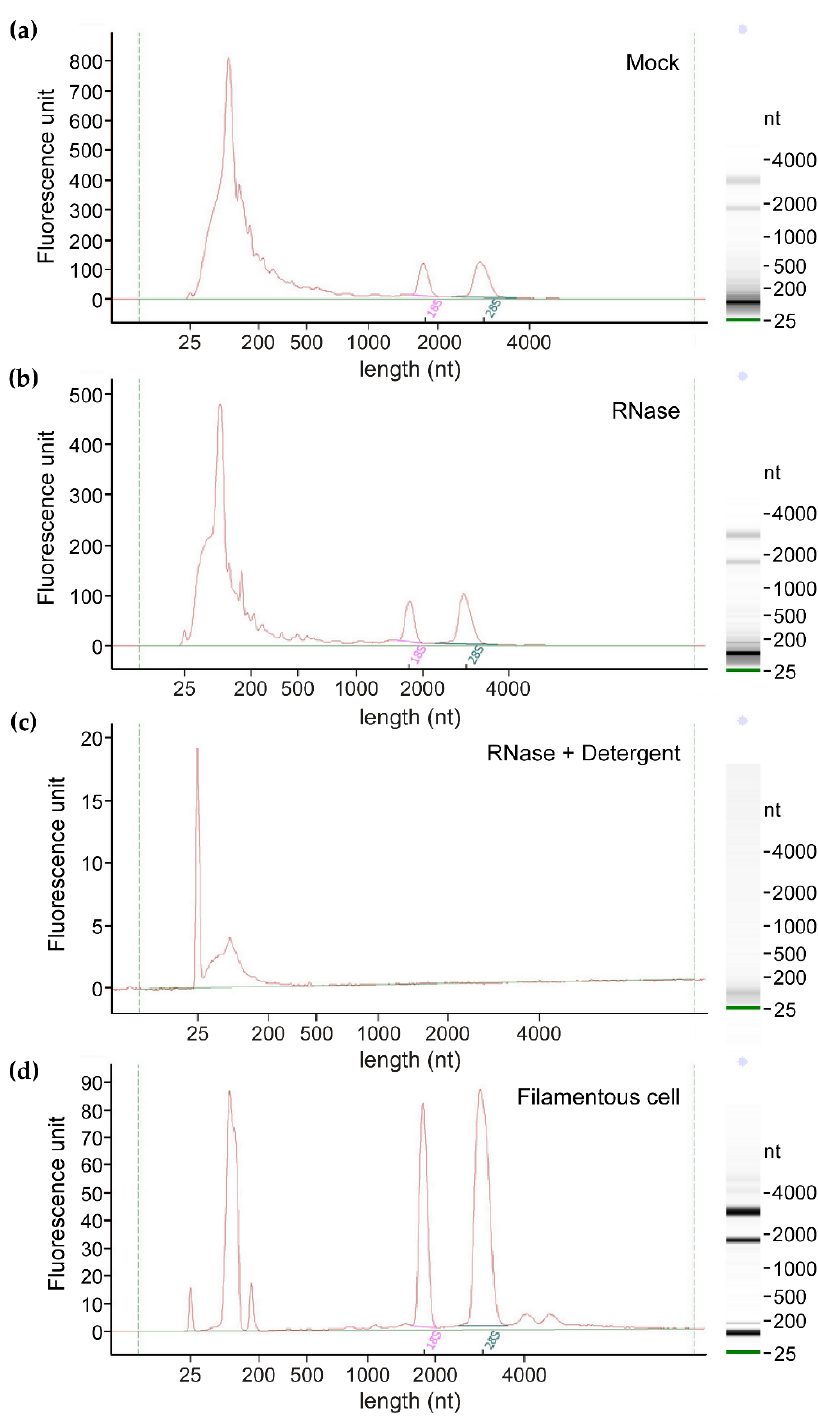
Figure 2. Extracellular RNA associated with U. maydis EVs. ( a ) Bioanalyzer profile of RNA extracted from EVs suspended in PBS, incubated with additional PBS as a mock treatment. ( b ) RNA from EVs treated with 0.1 µg/µL RNase A in PBS. ( c ) RNA from EVs treated with 0.1 µg/µL RNase A and 0.1% ( v / v ) triton X-100 in PBS. ( d ) Total RNA of induced hyphal filament cells, from which above EV samples were derived.